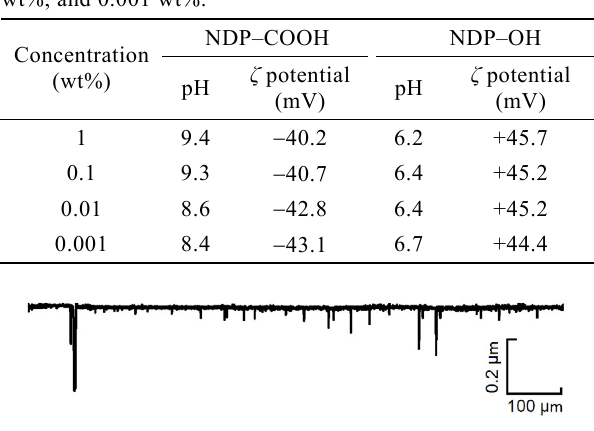
Fig. 3 Surface profile of SiC disk